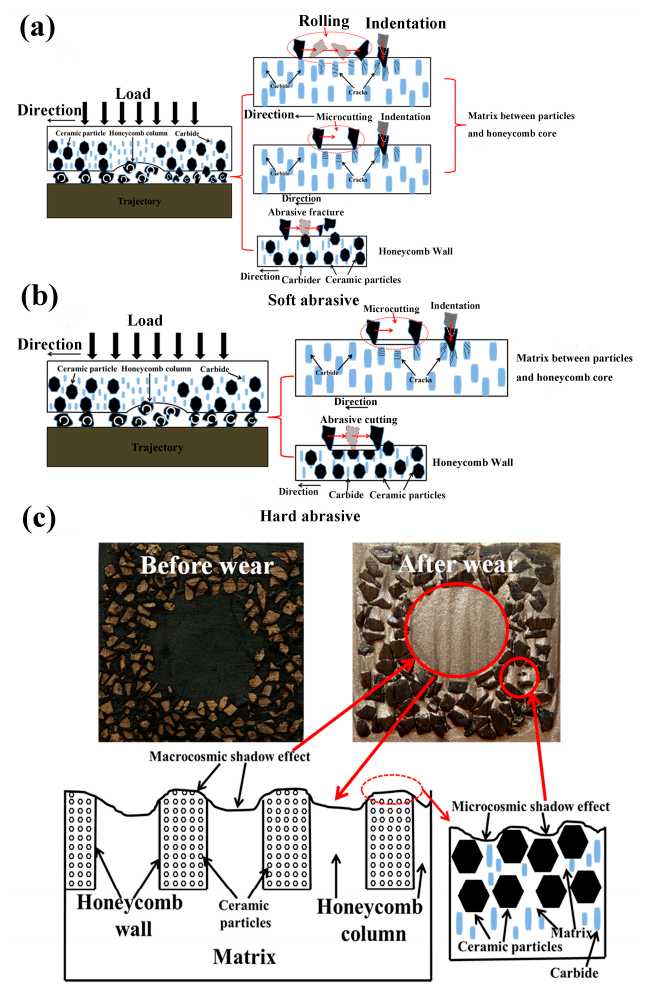
Figure 12. Two conditions of the failure of the honeycomb structural composite on the worn surface: ( a ) Soft abrasives; ( b ) Hard abrasives; ( c ) Shadow protected effect.